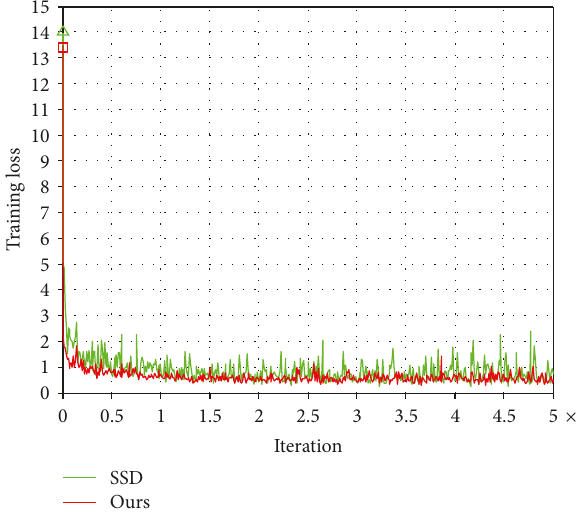
Figure 9: Comparison of training loss during training